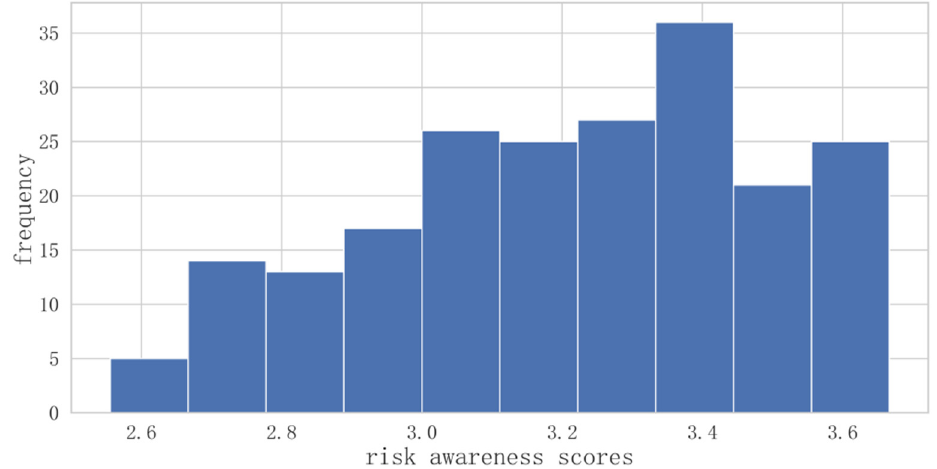
Figure 3. Distribution of risk awareness scores among consumers.